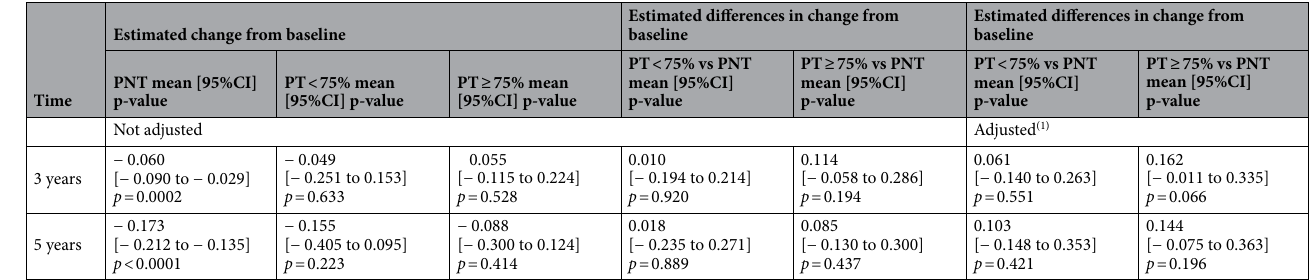
Table 2. Linear mixed models presenting changes of the composite cognitive score according to urate- lowering therapies administration among community-dwelling older adults. PNT: participants not treated; PT < 75: participants treated less than 75% of the study follow-up; PT ≥ 75: participants treated more than 75% of the study follow-up. (1) Adjustment for age, sex, body mass index (BMI), arterial hypertension, diabetes, allocation to MAPT intervention groups, baseline composite cognitive score and their interactions with time.